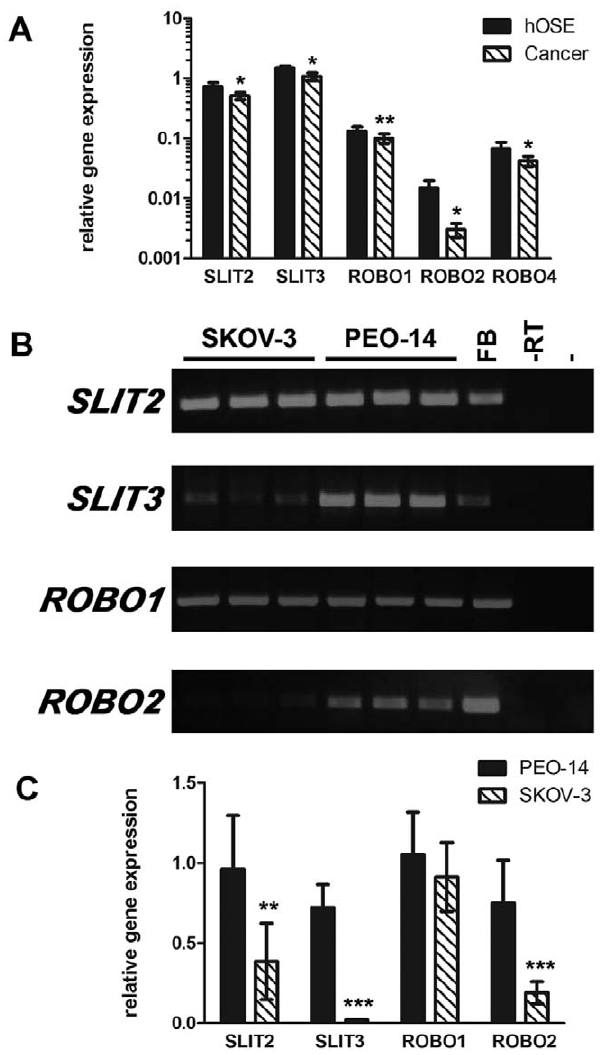
Figure 2. Expression of the SLITs and ROBOs in ovarian cancer. A ) Real-time quantitative PCR showing increased SLIT2 , SLIT3 , ROBO1 , ROBO2 and ROBO4 in primary cultures of hOSE compared to malignant epithelial cells cultured from the ascites of ovarian cancer patients. B ) RT-PCR showing that both the SKOV-3 and PEO-14 cell lines expressed SLIT2 , SLIT3 , ROBO1 and ROBO2 . C ) Real-time quantitative PCR showing SLIT2 , SLIT3 and ROBO2 transcripts were more abundant in the well differentiated PEO-14 cells compared to the poorly differentiated SKOV- 3 cells. FB=Fetal Brain positive control; -RT=RT negative negative control; -=DNA negative negative control; *= P , 0.05; **= P , 0.01; ***= P , 0.005.